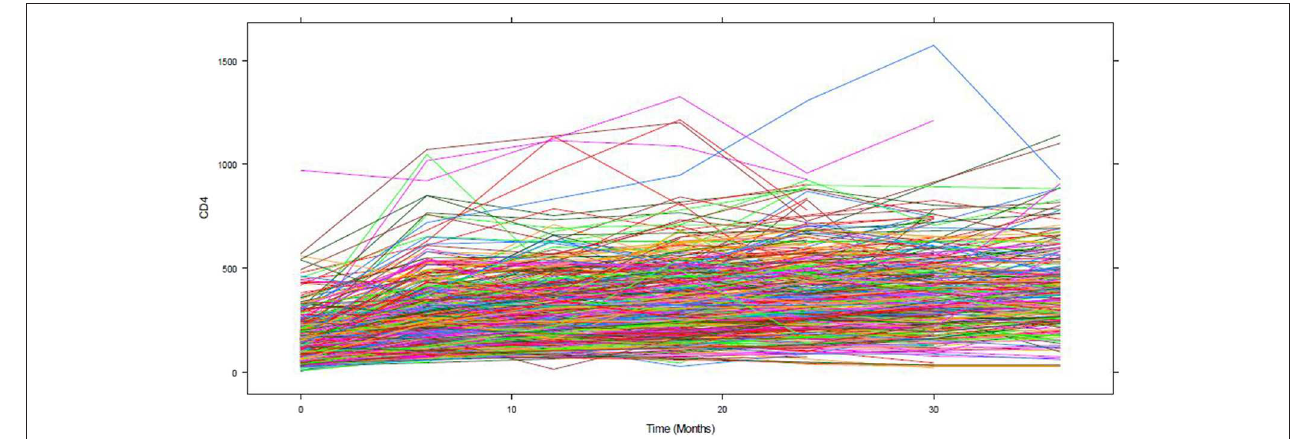
FIGURE 1 | The individual profile plot of CD4